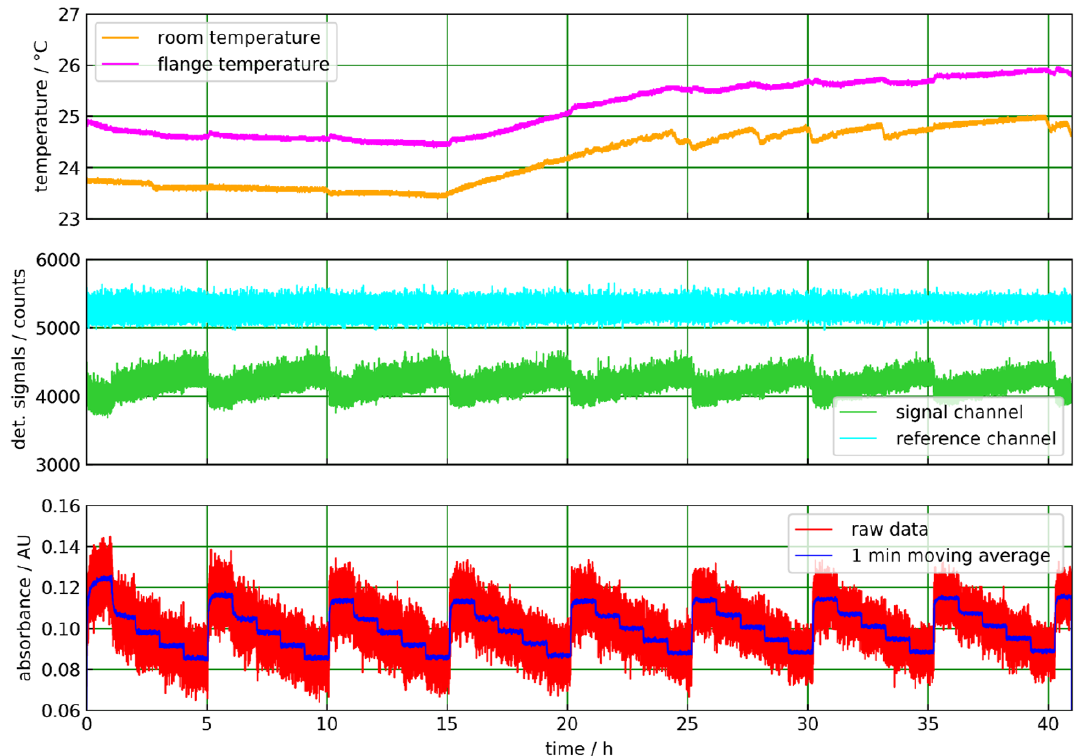
Figure 9. ATR measurement of pure CO 2 gas with the sapphire tube in reflection geometry. Ambient and flange temperatures are shown in the ( top ) part. The detector signal channel shows characteristic steps when the CO 2 pressure is varied in 1-bar steps from 5 bar absolute to ambient pressure. The reference channel is not affected by the pressure variations and stays constant ( middle ). In the absorbance plot the pressure steps are clearly resolved by a 1-min moving average ( bottom ).